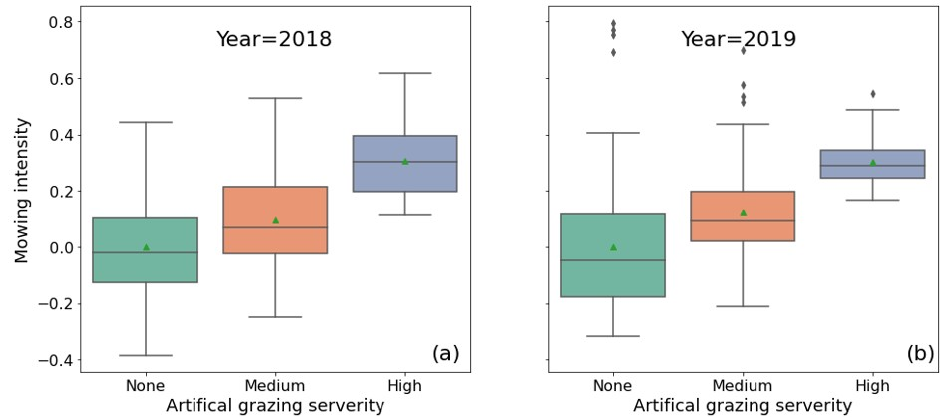
Figure 4. The mowing intensity modification ratio (F): ( a ) the year of 2018; ( b ) the year of 2019.